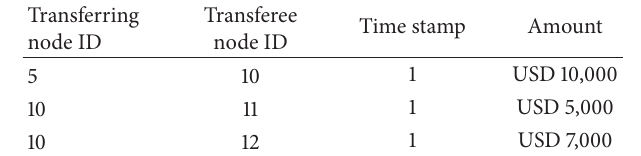
Table 3: Telephonic conversation database.